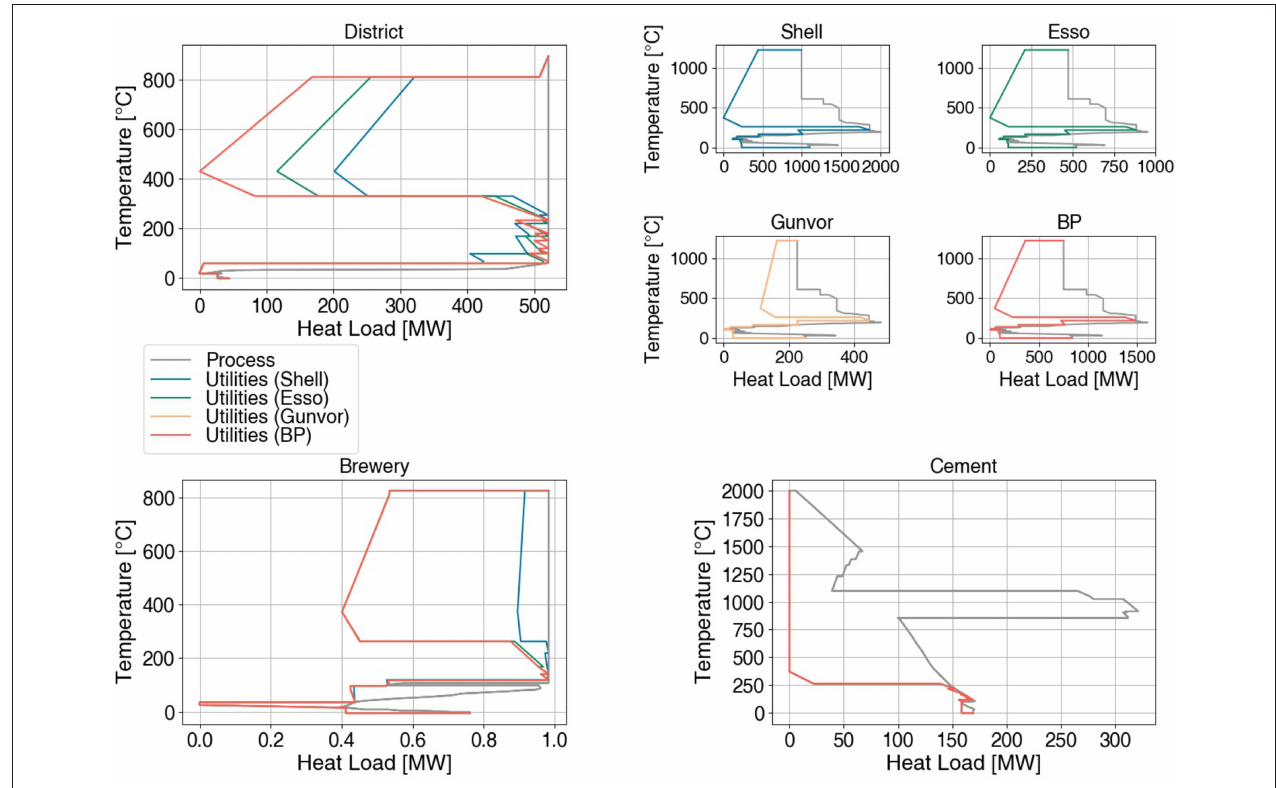
FIGURE 14 | Integrated composite curve of the processes considered, refinery/cement plant couples considered individually.